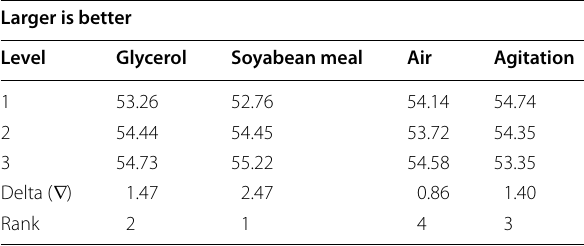
Table 5 Response Table for Signal to Noise Ratio of Setomimycin production by Streptomyces sp. RA-WS2 Larger is better